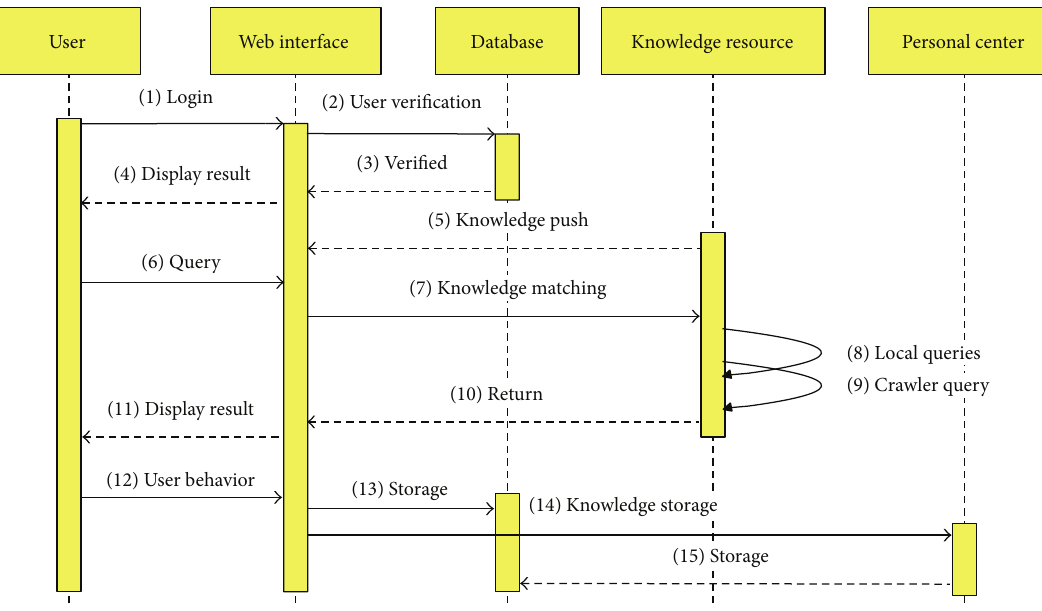
Figure 6: Knowledge push based on user